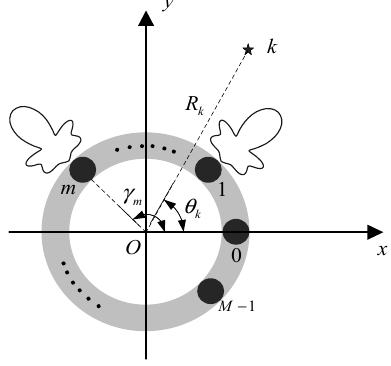
Figure 1. Radar array geometry diagram.